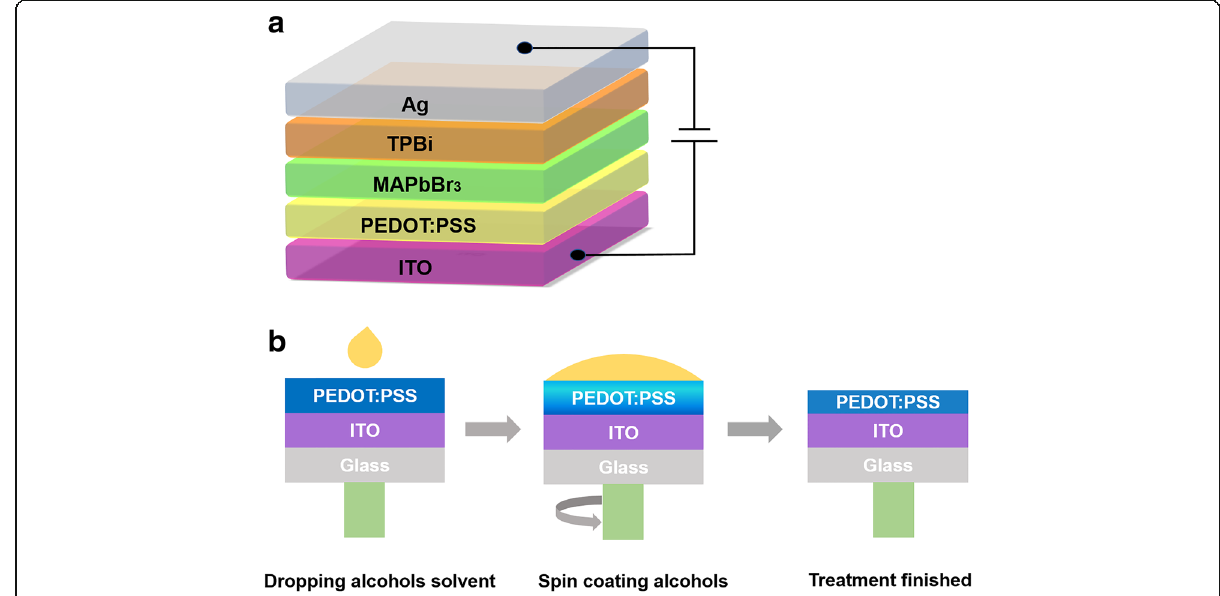
Fig. 1 a Device structure of PeLEDs. b Process of spin coating alcohol solvent on PEDOT:PSS